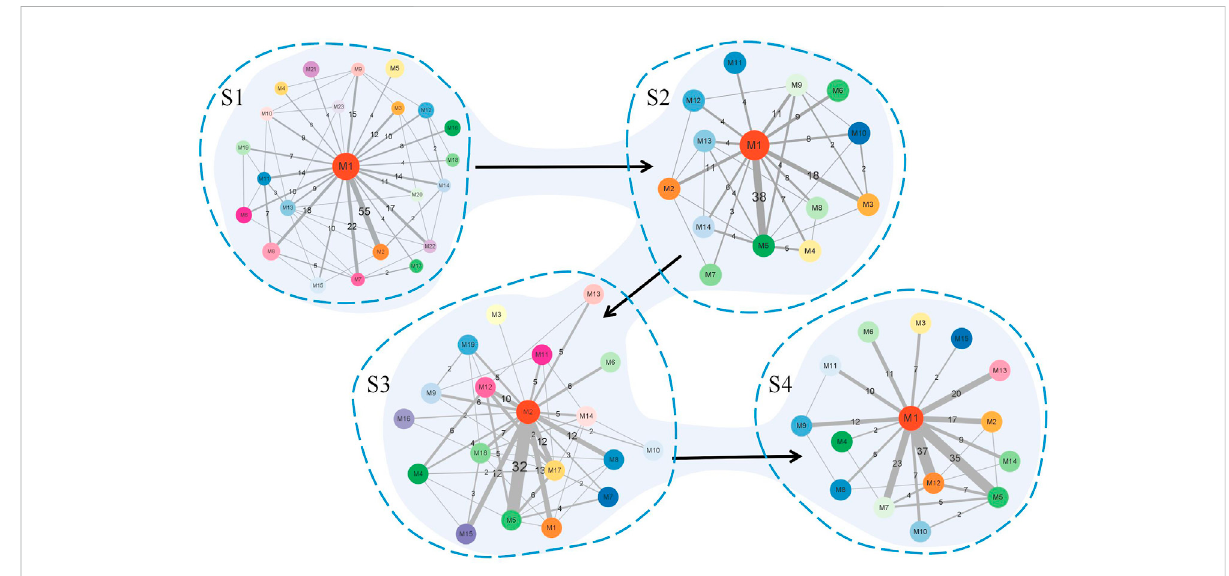
FIGURE 8 Summary fi gure of thesimpli fi edmodule networks inthefour stages.The fi gure contains four simpli fi edmodule networks, eachrepresenting a corresponding stage, with arrows marking the progression of the disease according to the order S 1 → S 2 → S 3 → S 4.